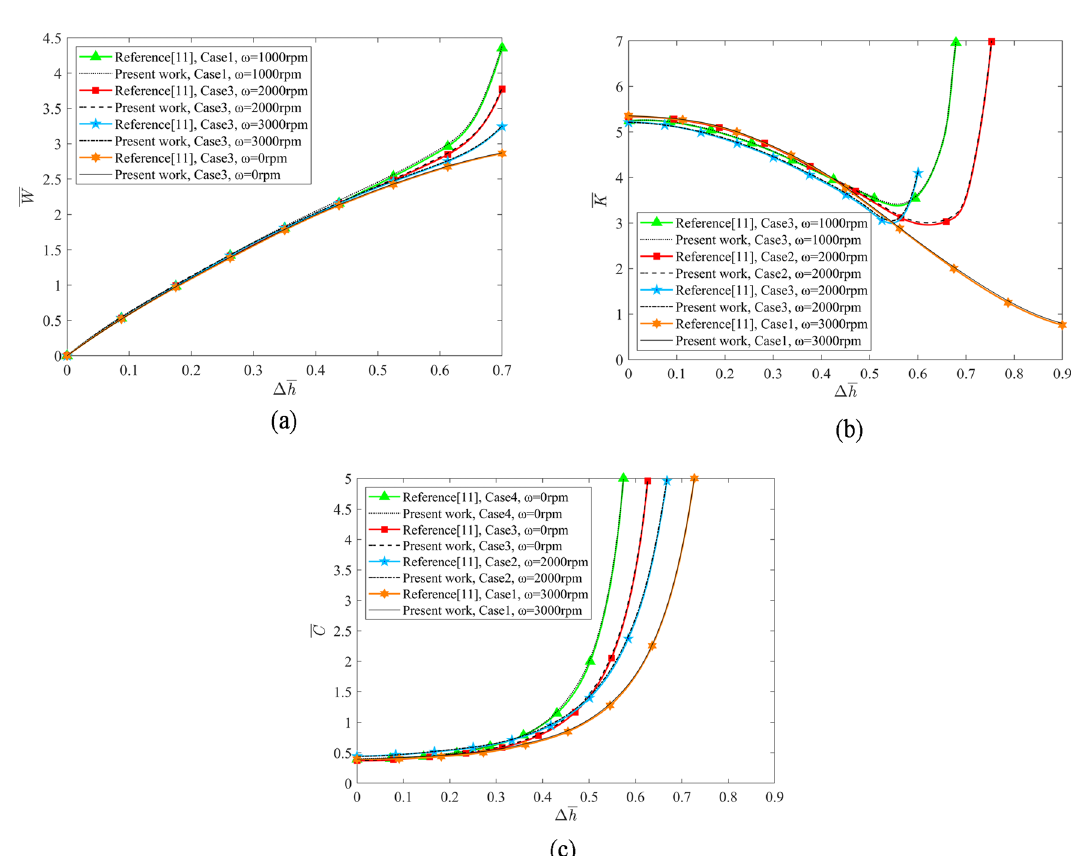
Figure 9. Comparison of bearing capacity, stiffness coefficient and damping coefficient of hydrostatic lead screw with Ref. 11 ( a ) Bearing capacity ( b ) Stiffness coefficient ( c ) Damping